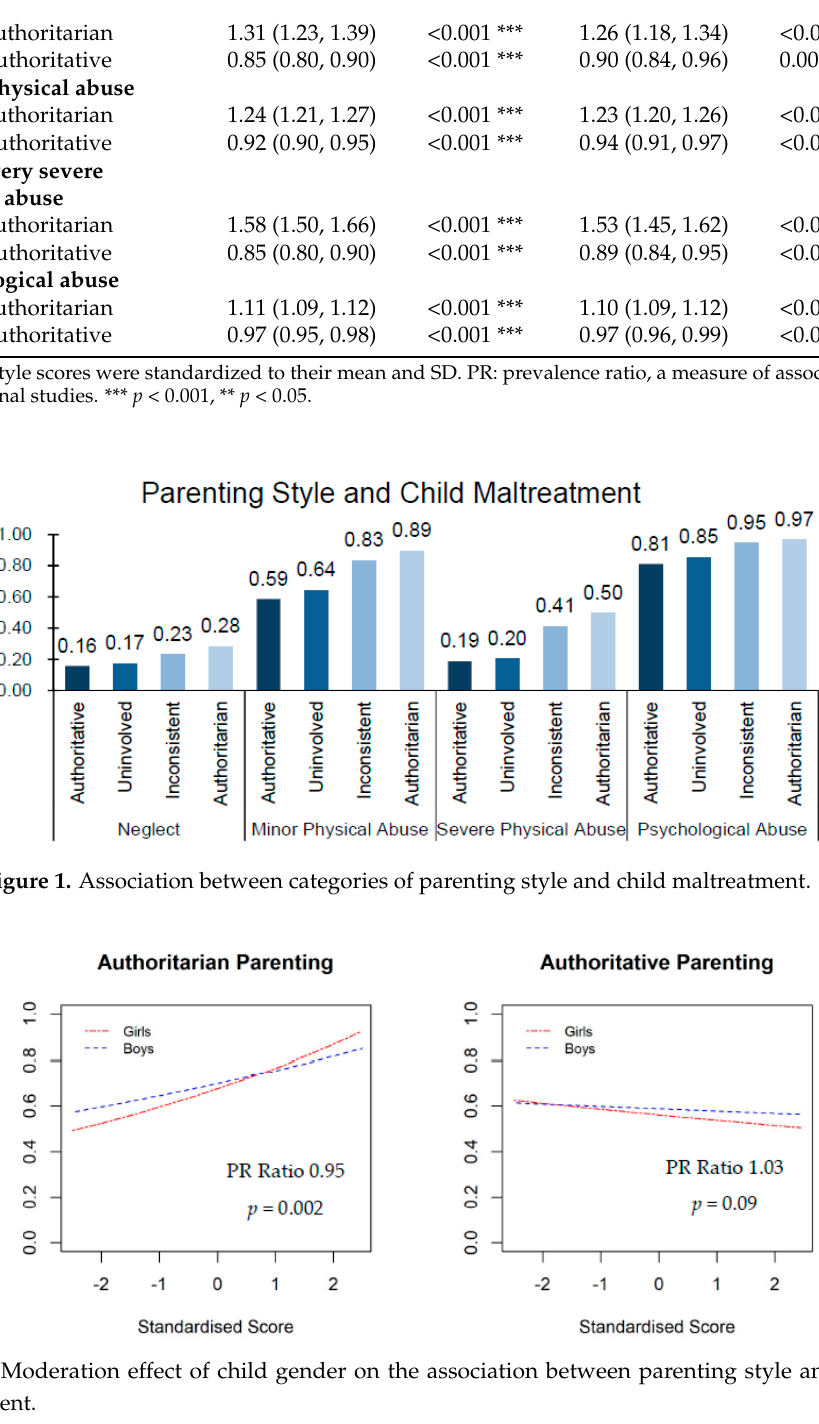
Figure 2. Moderation effect of child gender on the association between parenting style and child maltreatment. Figure 3. Moderation effect of family socioeconomic status on the association between parenting style and child maltreatment.